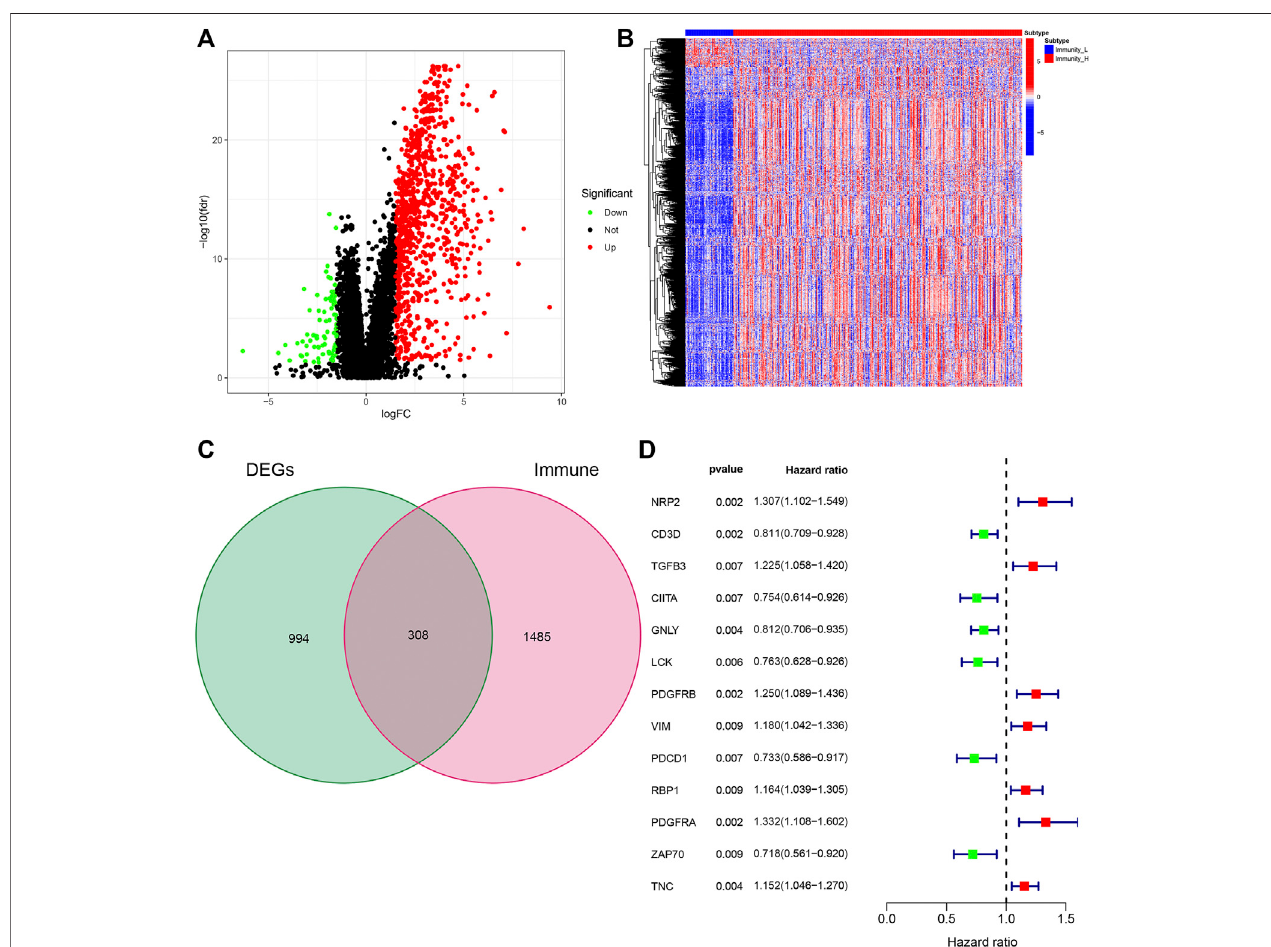
FIGURE2|(A) Volcano plotofalldifferentially expressed genes(DEGs) showingthelog2 (foldchange)and FDR valueofeach gene. (B) DEGsexpression between the two subtypes in the heat maps. (C) Veen plot based on the intersection of DEGs and human immune genes. (D) Forest plot based on univariable Cox proportional hazards regression analysis showing the prognosis-related immunity genes (PIMGs) and their hazard ratios.